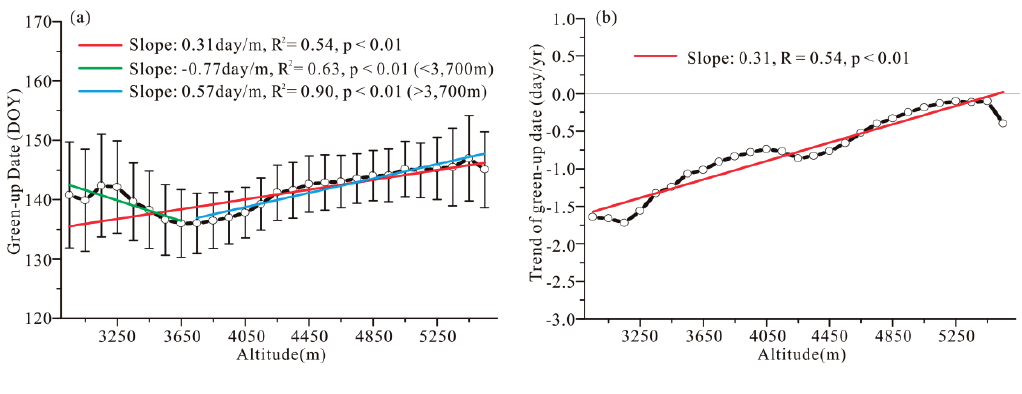
Figure 5. Altitudinal gradient in the green-up date and its trend over the TRHR (the error bar denotes the standard deviation of the green-up